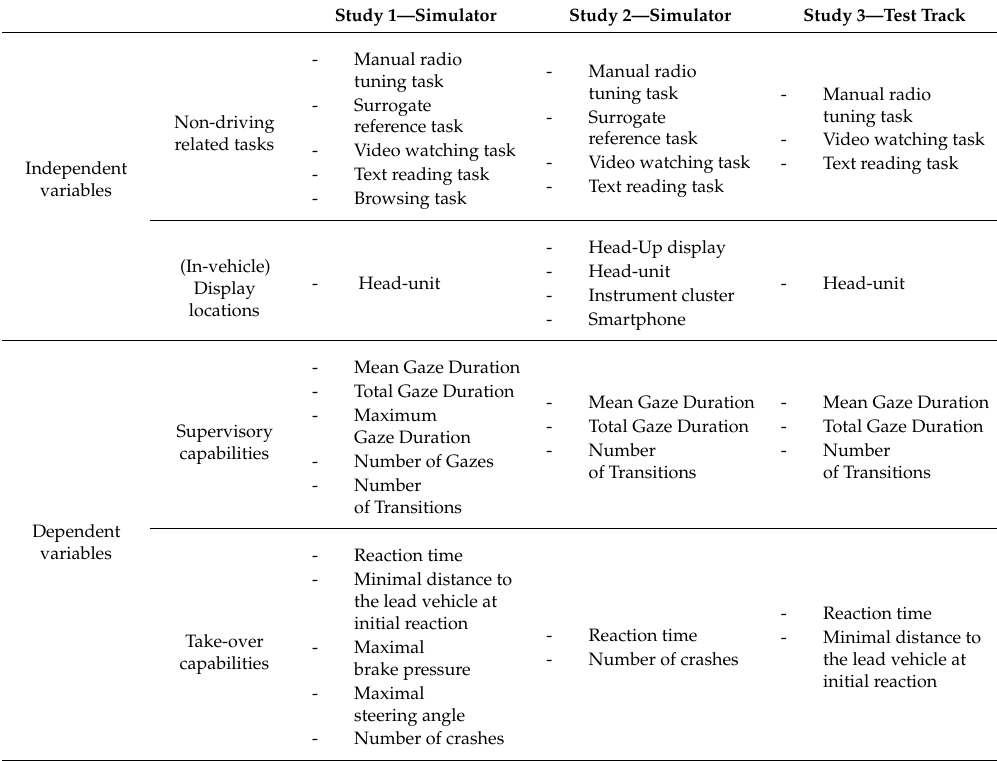
Table 2. Overview of the independent and dependent variables addressed and assessed within the three